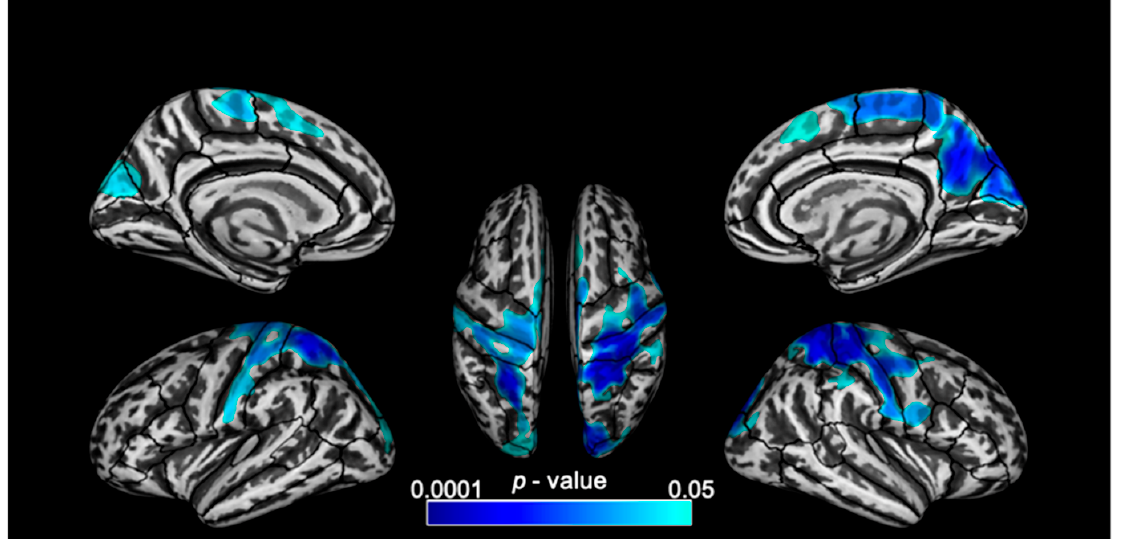
Figure 1. Lateral, medial and superior views of the brain with clusters of significant ( p < 0.05, corrected for multiple comparisons) negative correlation between cortical thickness and EXE scores (from the Attention Network Test for Interaction) overlaid on inflated